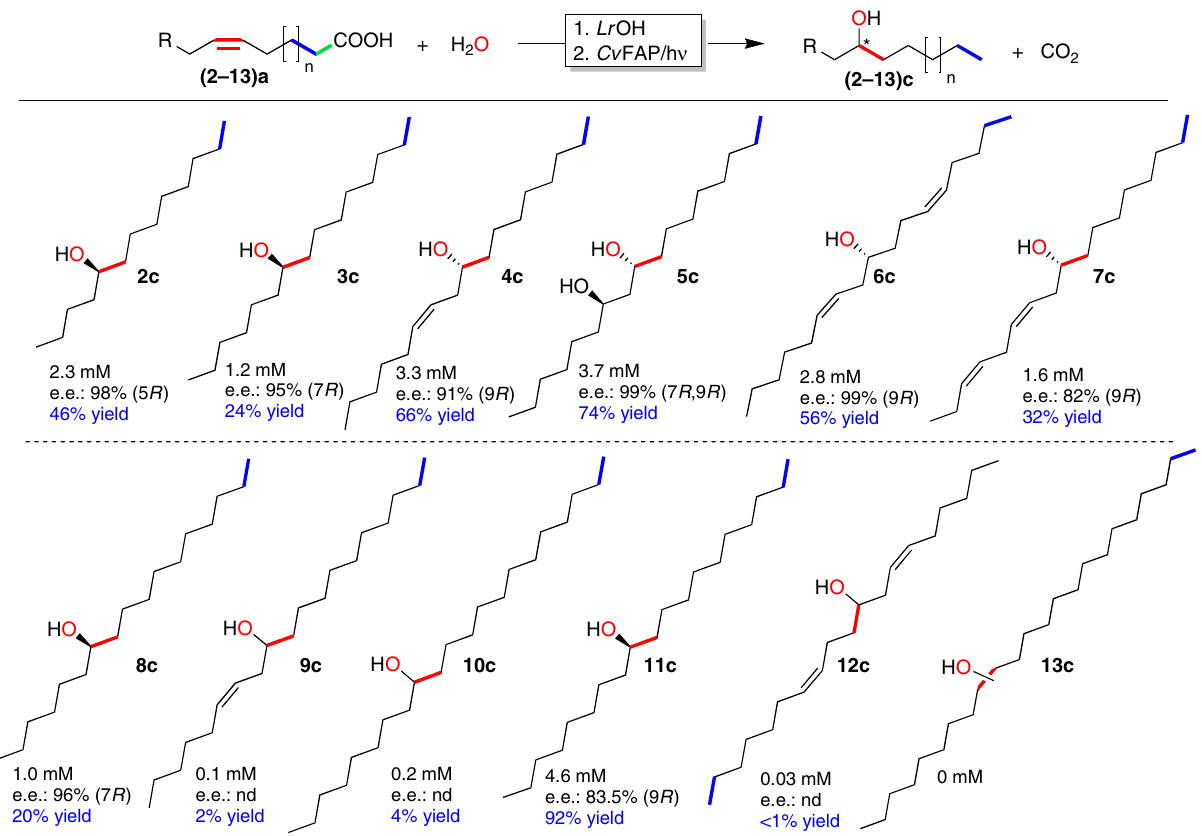
Fig. 4 Preliminary product scope of the proposed photoenzymatic reaction system. Reaction conditions: [substrate] = 5 mM, [LrOhyA-cells] = 20 g L − 1 , [ Cv FAP] = 2 µ M, Tris-HCl buffer (100 mM, with 50 mM of NaCl), blue light ( λ = 450 nm; intensity = 13.7 mE L − 1 s − 1 ). The reactions were performed in